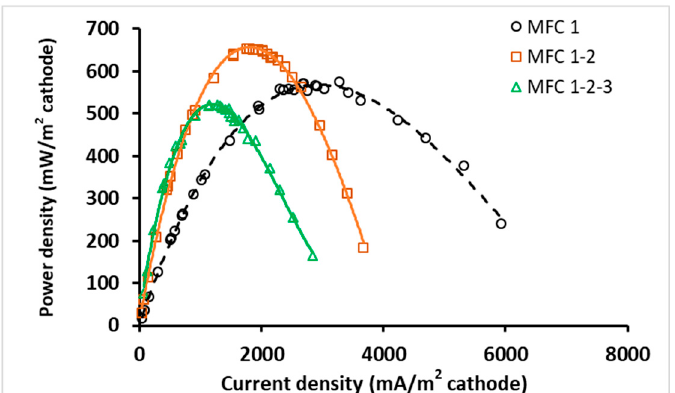
Figure 6. Power density for the MFC 1, MFC 1-2, and MFC 1-2-3 settings.